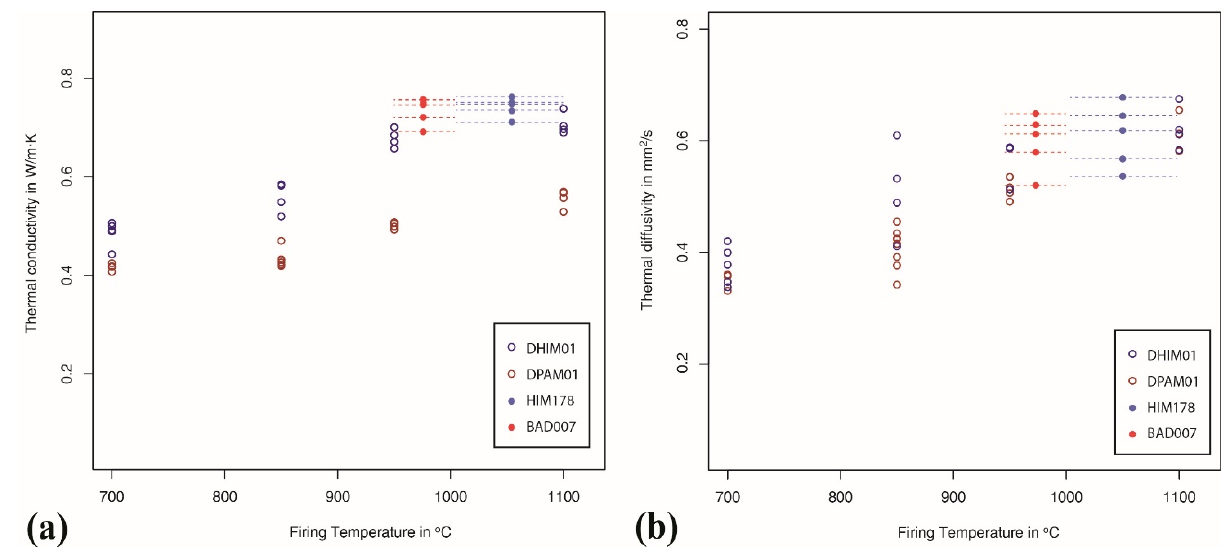
Figure 17. Thermal conductivity ( a ) and thermal diffusivity ( b ) measured in the fired geological specimens and in the two archaeological individuals HIM178 and BAD007: the values are plotted versus firing temperature and the EFT estimated for the two archaeological individuals. Raw data are available in [106].